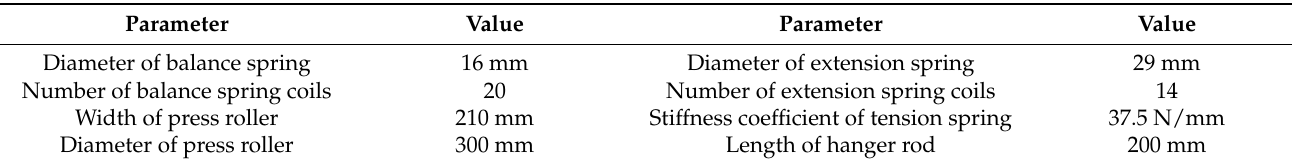
Table 1. Structural parameters of the BPPD.